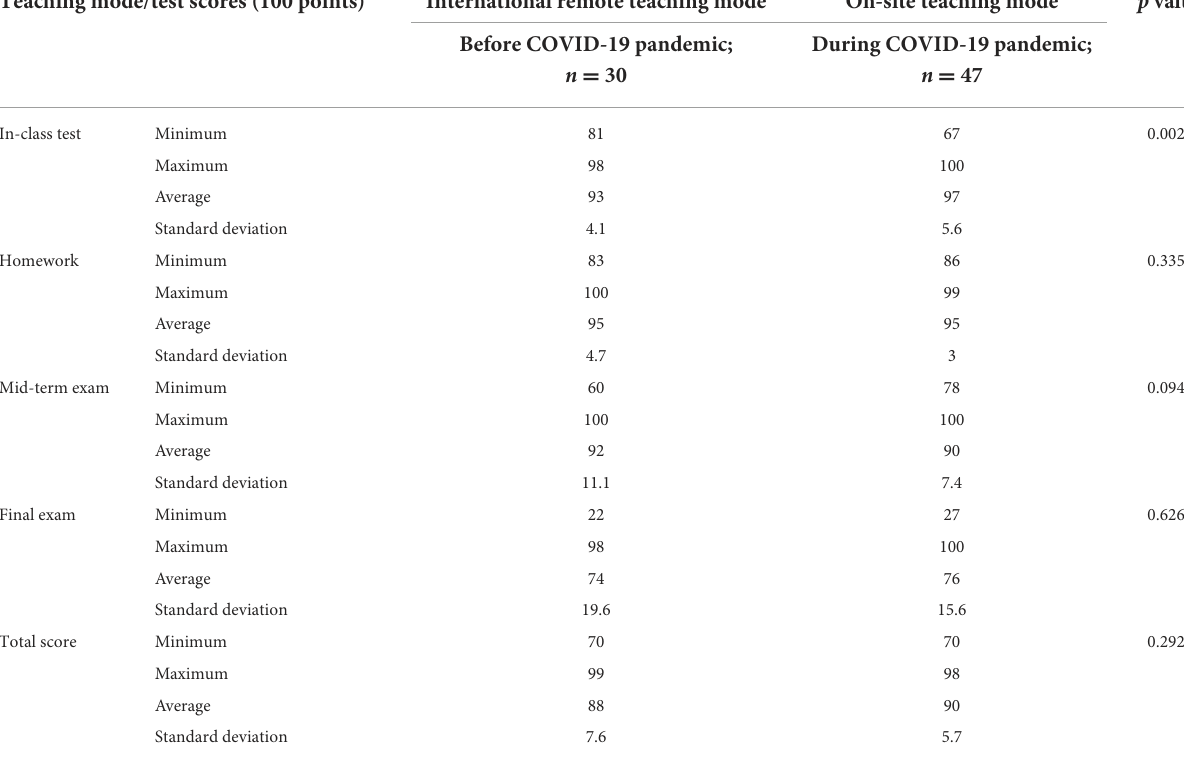
TABLE 1 Test scores of curriculum ultrasound physics and hemodynamics between two teaching modes. Teaching mode/test scores (100